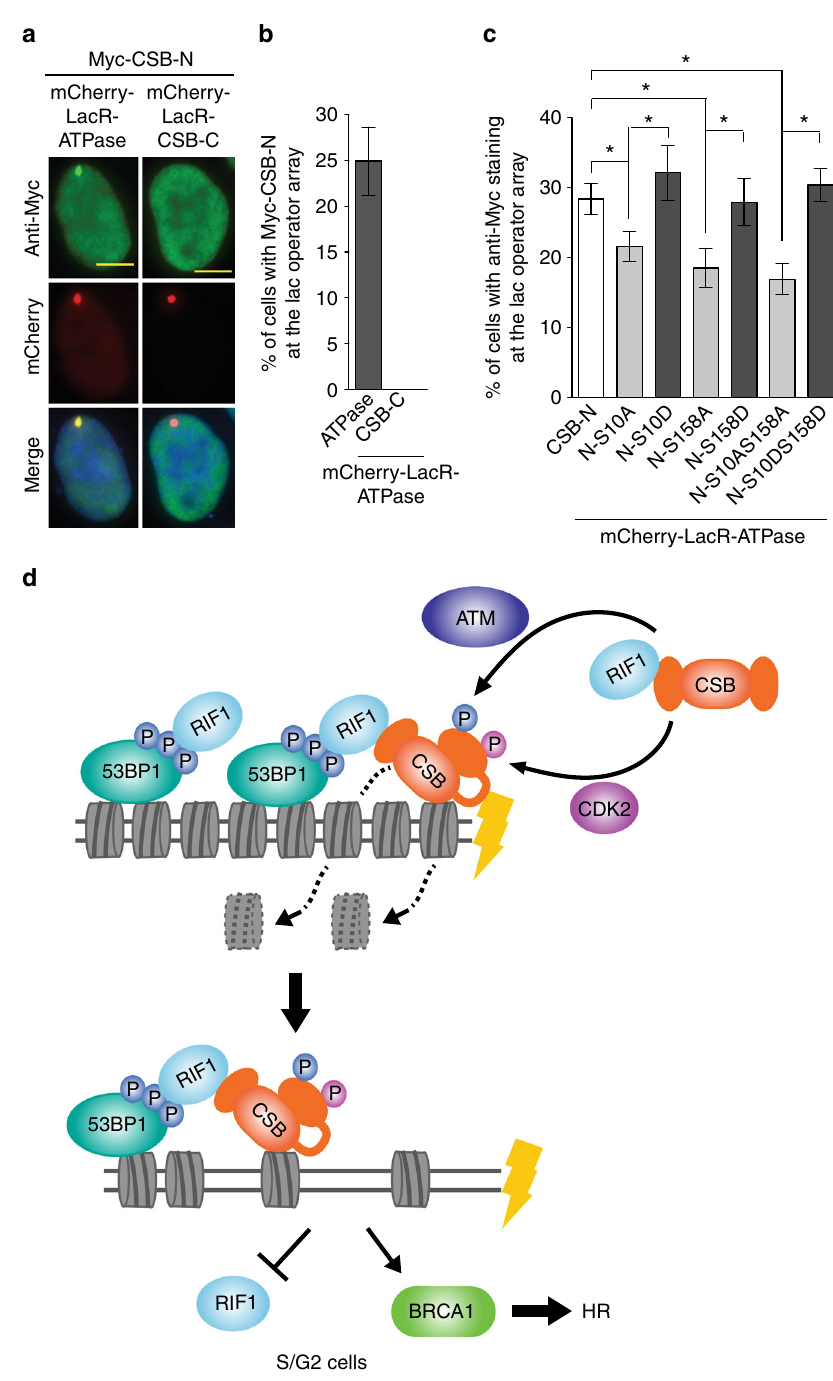
Fig. 9 CSB phosphorylations on S10 and S158 modulate the interaction of the N-terminus with the ATPase domain. a Immuno fl uorescence of U2OS-265 cells transfected with Myc-CSB-N in conjunction with either mCherry-LacR-CSB-ATPase or mCherry-LacR-CSB-C. Scale bars, 5 μ m. b Quanti fi cation of the percentage of U2OS-265 cells from a with anti-Myc staining at FokI-induced DSBs. A total of 250 Myc-expressing cells were scored for each independent experiment in a blind manner. SDs from three independent experiments are indicated. c Quanti fi cation of the percentage of U2OS- 265 cells with anti-Myc staining at FokI-induced DSBs. U2OS-265 were co-transfected with various alleles as indicated. A total of 250 Myc-expressing cells were scored for each independent experiment in a blind manner. SDs from three independent experiments are indicated. * P < 0.05 (Student t test). d Model for control of CSB chromatin remodeling activity by ATM and CDK2 in DNA DSB repair pathway choice in S/G2. See the text for